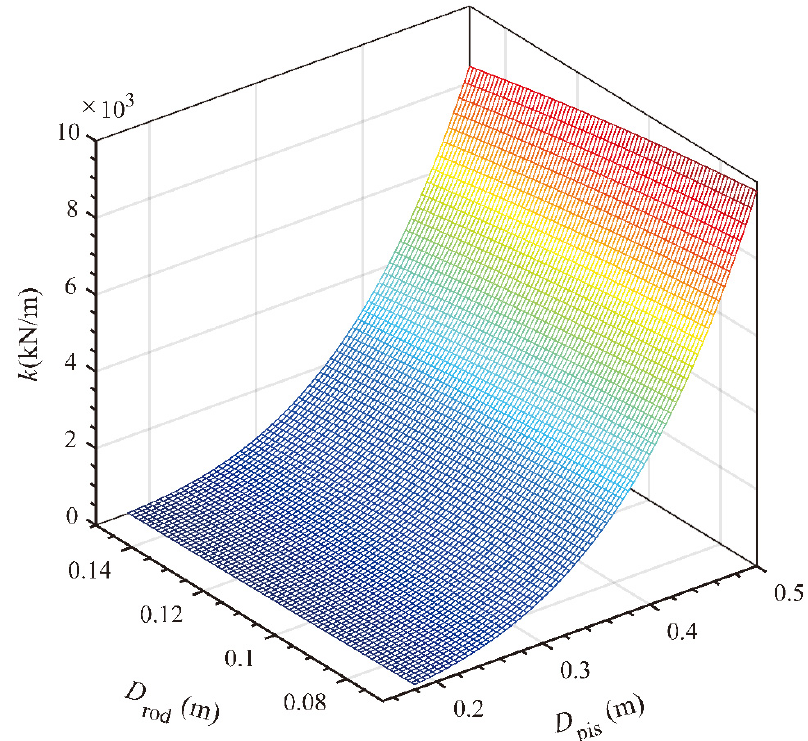
Figure 14. Effects of the piston diameter and rod diameter, D pis and D rod , on the stiffness coefficient, k.